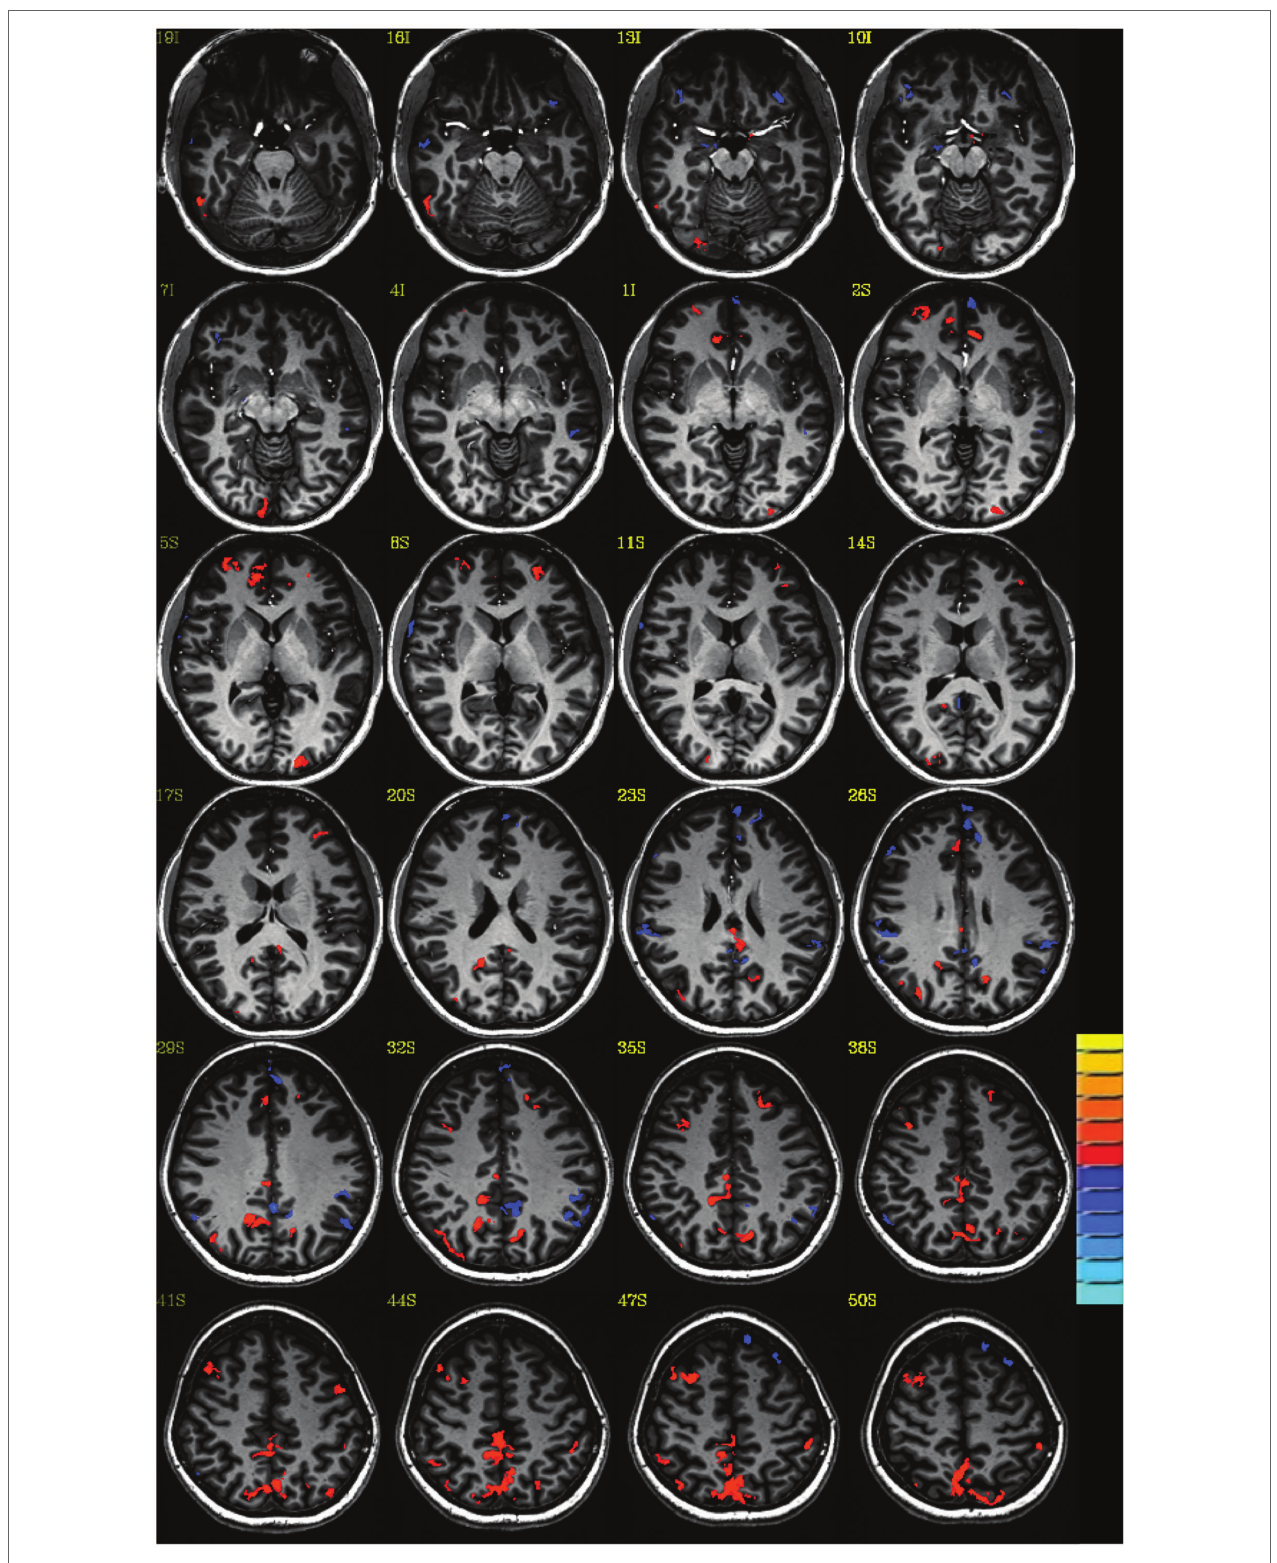
FIGURE 1 | Default mode connectivity: Z-score group difference map: Lost consciousness vs. not lost consciousness head trauma. Single voxel threshold p < 0.05, cluster requirement